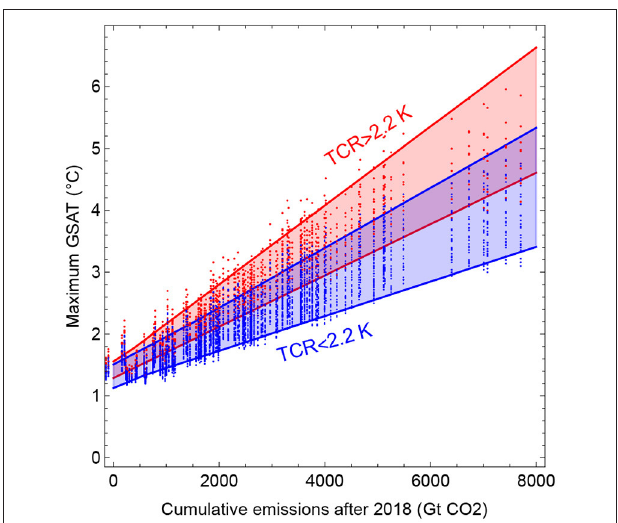
FIGURE 7 | Each column of points shows maximum GSAT for a given emission scenario, so their spread indicates the variance over the ensemble of ESMs. The red points are for ESMs with TCR ≥ 2.2 K, and the blue points for ESMs with TCR < 2.2